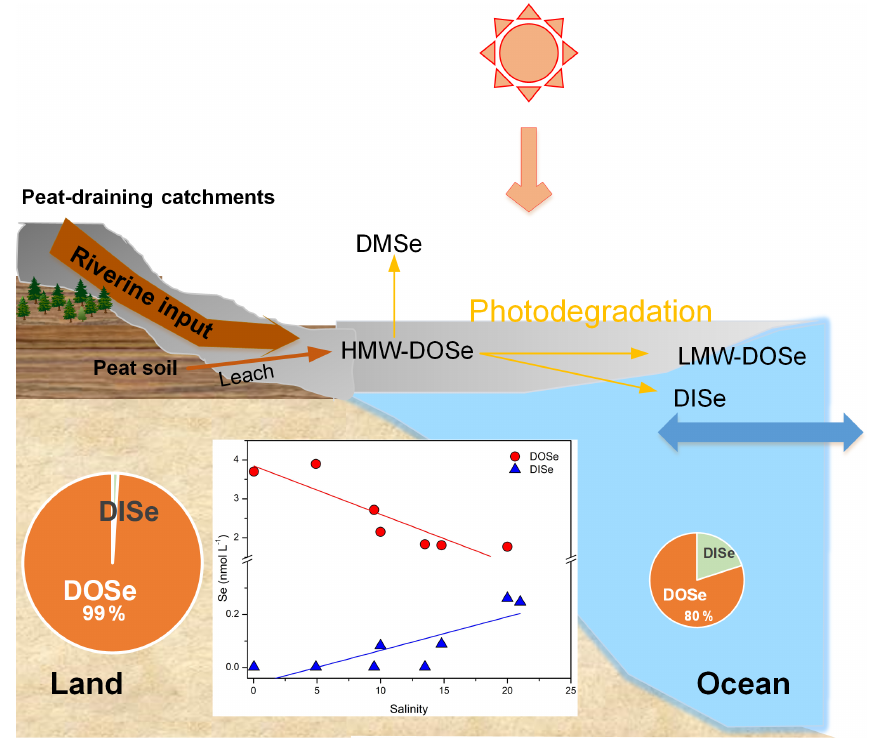
Figure 6. Conceptual diagram of the behaviour of Se species in the Maludam estuary. HMW, LMW and DMSe represent high molecular weight, low molecular weight and dimethylselenide,